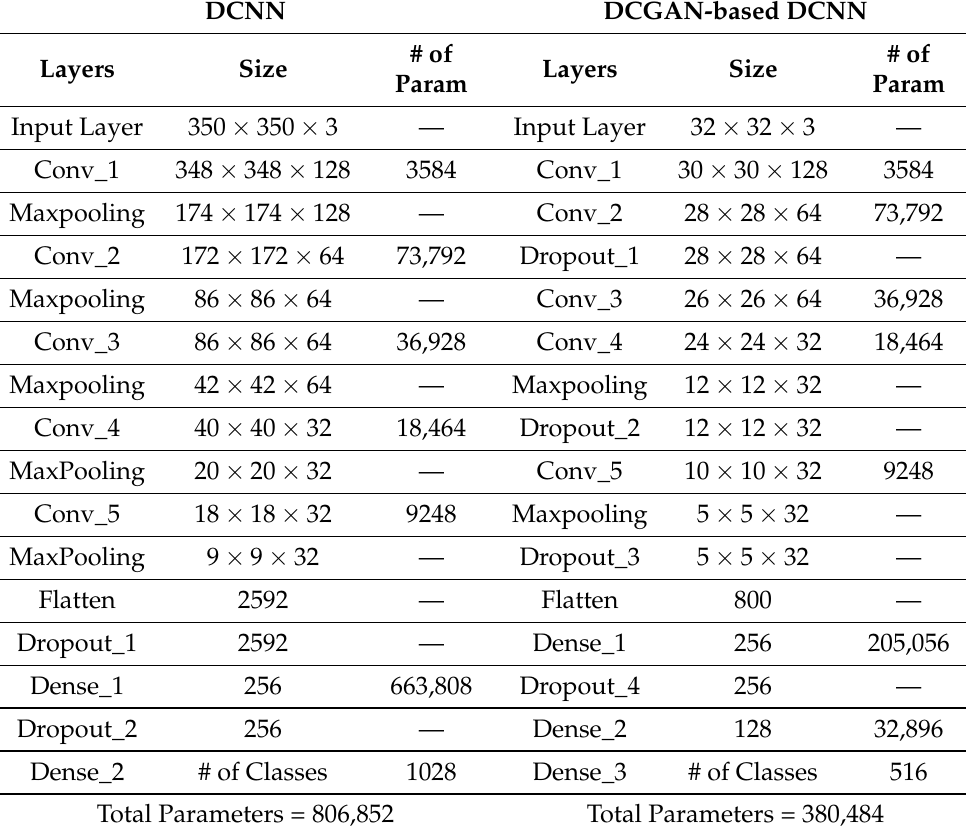
Table 1. The summary of the proposed